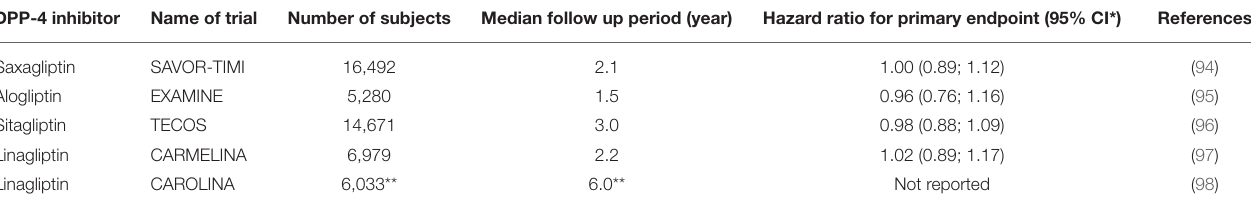
TABLE 3 | Cardiovascular outcomes trials with DPP-4 inhibitors, name, number of subjects, and duration. DPP-4